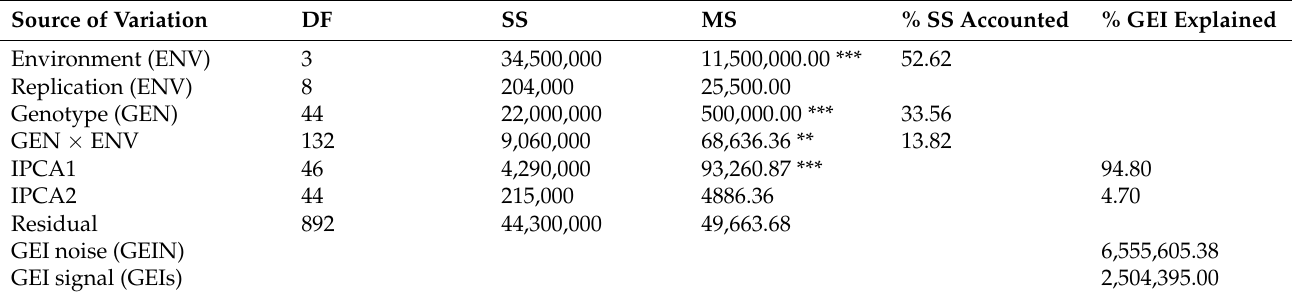
Table 4. AMMI analysis of variance with explained variation in seed yield of tepary bean accessions evaluated in four